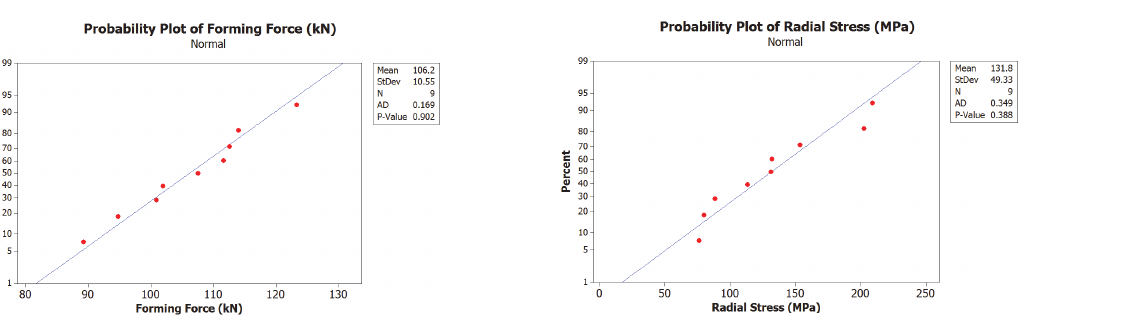
Fig. 9. Probability plot of Forming Force (FF) Fig. 10. Probability plot of Radial